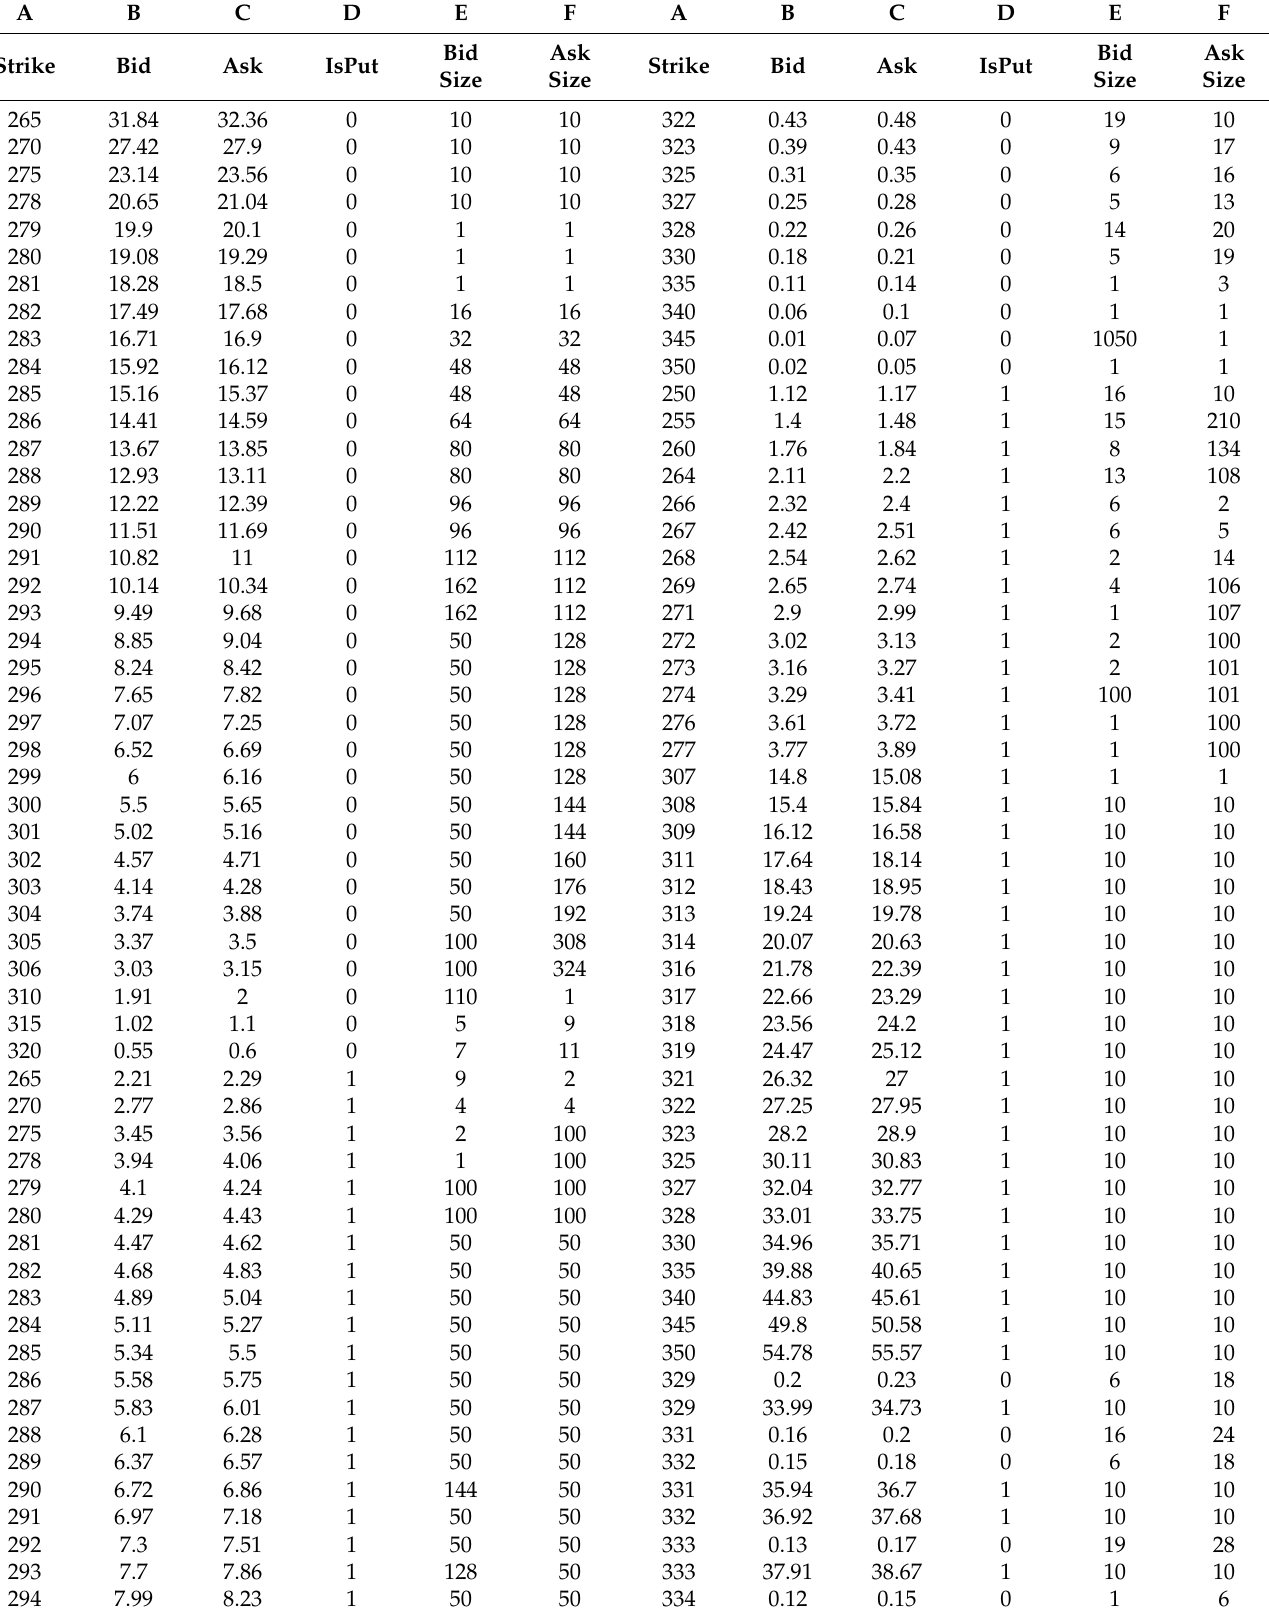
Table A1. Taken from Bloomberg terminal on the 19 May 2020 at 12:00:01 Bangkok